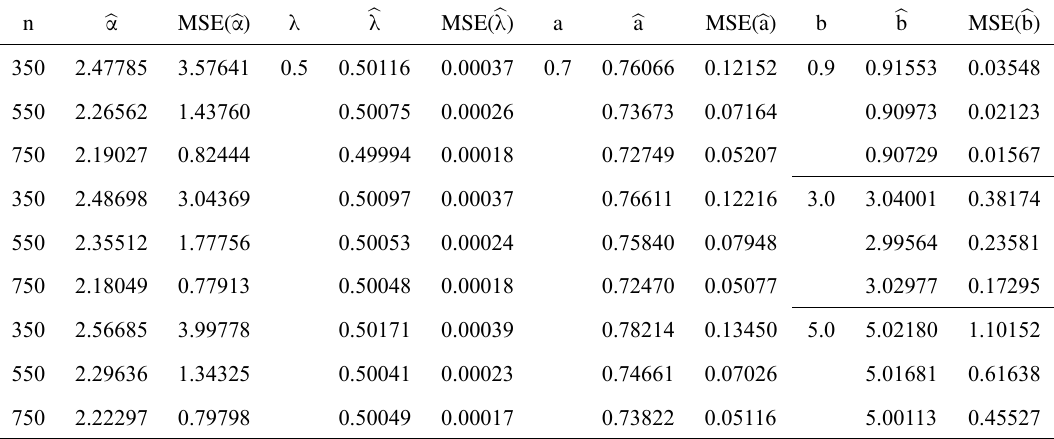
Average values of the MLEs and the corresponding MSEs for α = 2 and (n=350, 550 and